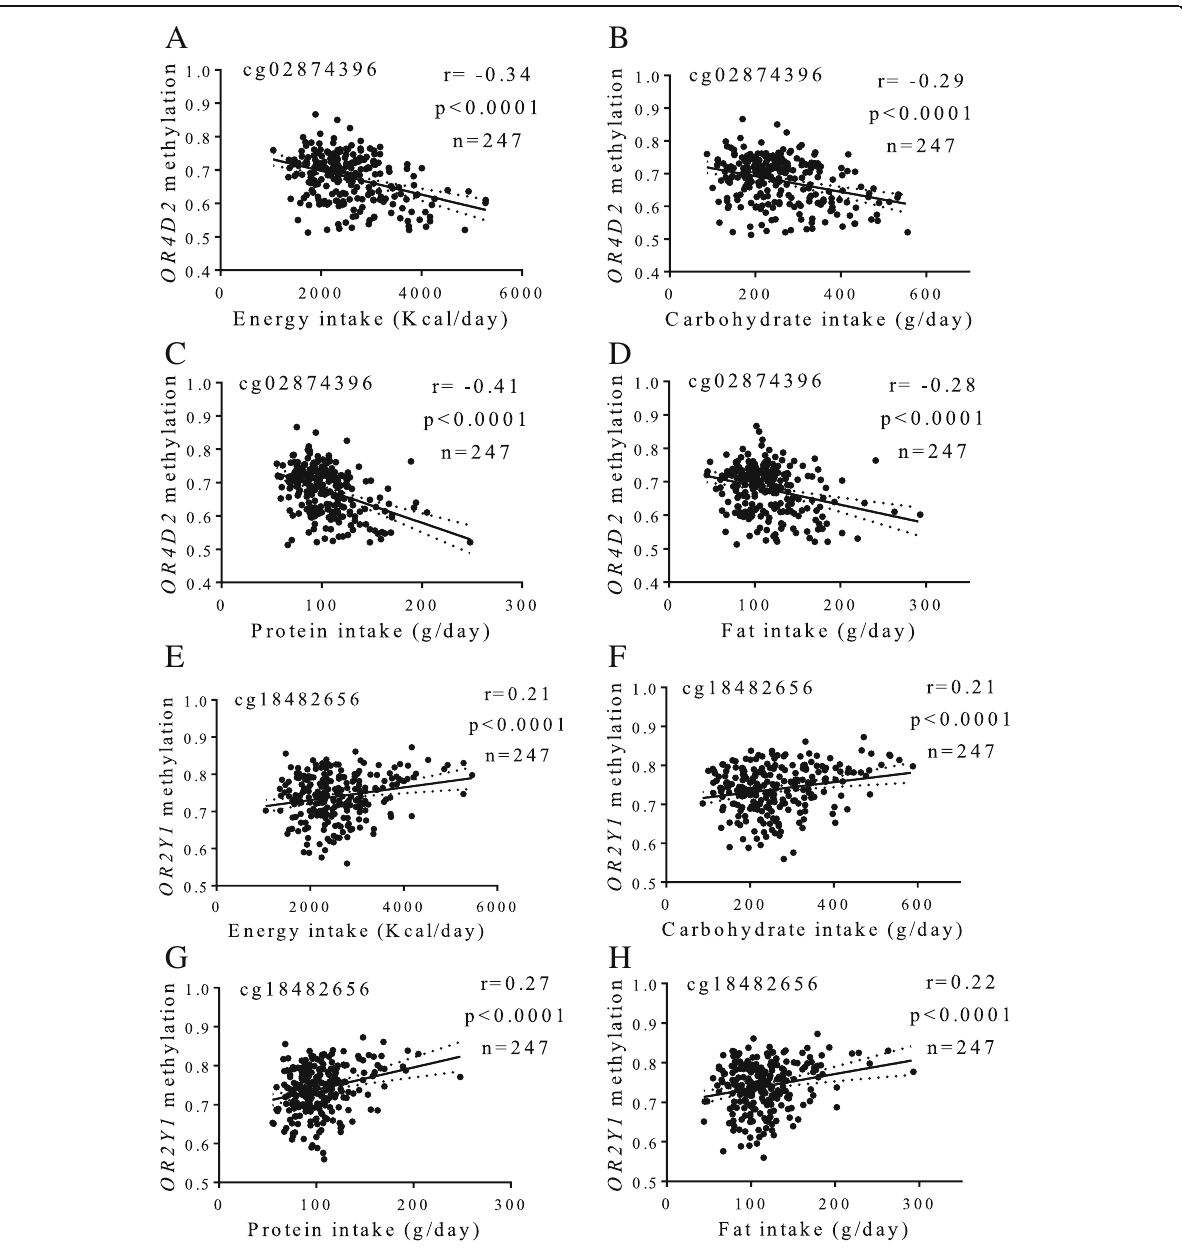
Fig. 4 Associations between methylation levels (beta values) at olfactory receptors and dietary intakes. a – d cg02874396, OR4D2 ( e – h